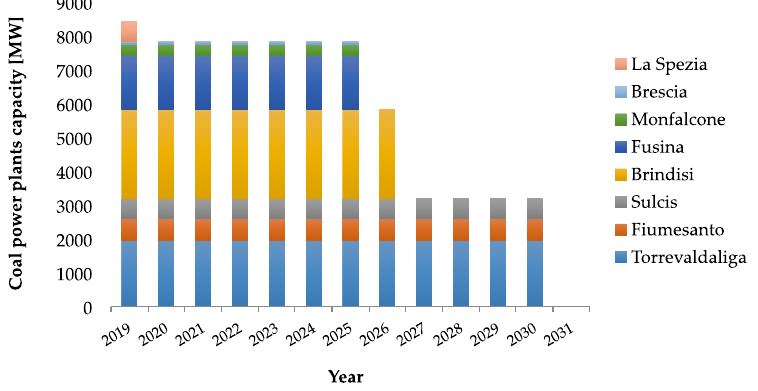
Figure 6. Decommissioning schedule of the Italian coal-fired power plants [53].